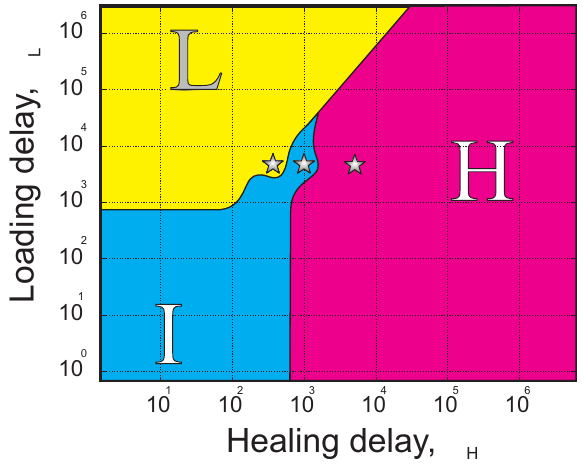
Fig.10. Threeseismicregimes: sampleofearthquakesequences. Toppanel–regime H (High), ∆ H = 0 . 5 · 10 4 ; middle panel – regime I (Intermittent), ∆ H = 10 3 ; bottom panel – regime L (Low), ∆ H = 0 . 5 · 10 3 . Only a small fraction of each sequence is shown, to illustrate the differences between regimes. Reproduced from Zaliapin et al. (2003a), with kind permission of Springer Science and Business Media.